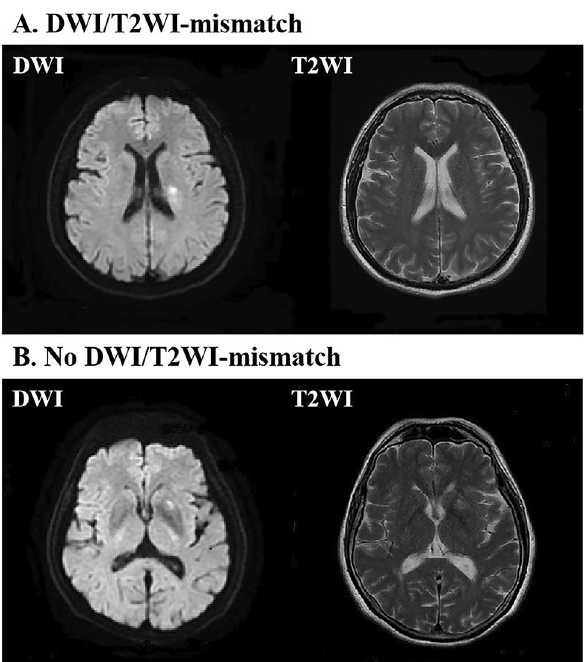
Figure 1. MRIs of patients with LSA stroke, with or without mismatch between DWI and T2WI within 12 h after onset of symptoms. ( A ) Pairs of images showing acute ischemic lesions on DWI but not on T2WI imaging (i.e., with DWI/T2WI-mismatch). ( B ) Pairs of images showing acute ischemic lesions on DWI together with a corresponding hyperintensity on T2WI imaging (without